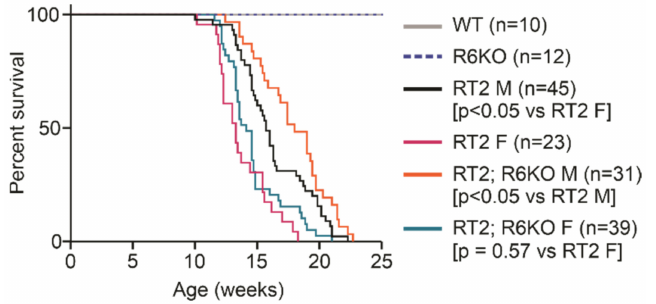
Figure 2. Loss of RABL6A improves survival of RT2 mice. Kaplan–Meier survival curves of overall survival for the indicated mice through 25 weeks after birth. All WT and R6KO mice were healthy and alive during this period. The Kaplan–Meier method was used to estimate the survival curves and group comparisons were made using the log rank test. p values for the indicated comparisons are shown; (n), number of animals in each